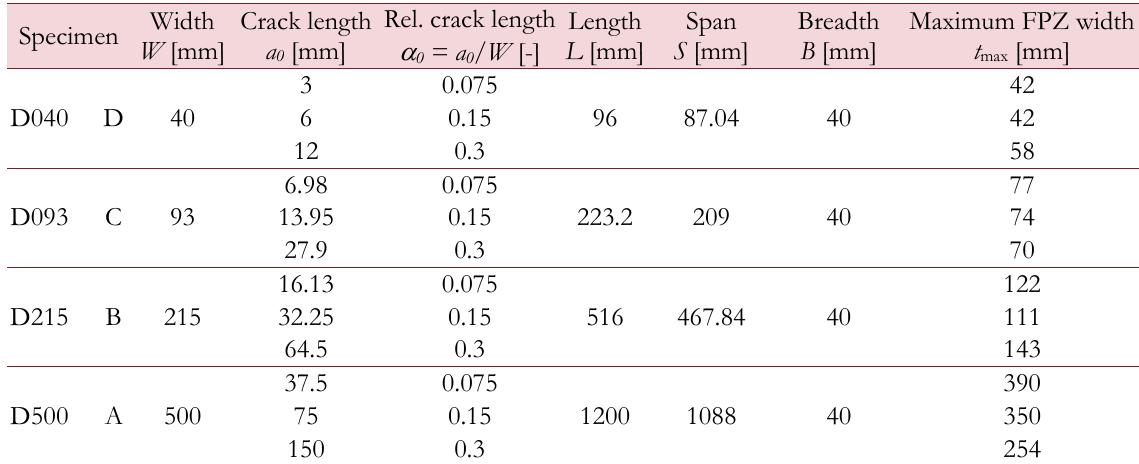
Table 1: Nominal dimensions of specimens from experiment [24]; estimated maximal widths of FPZ are shown in the right